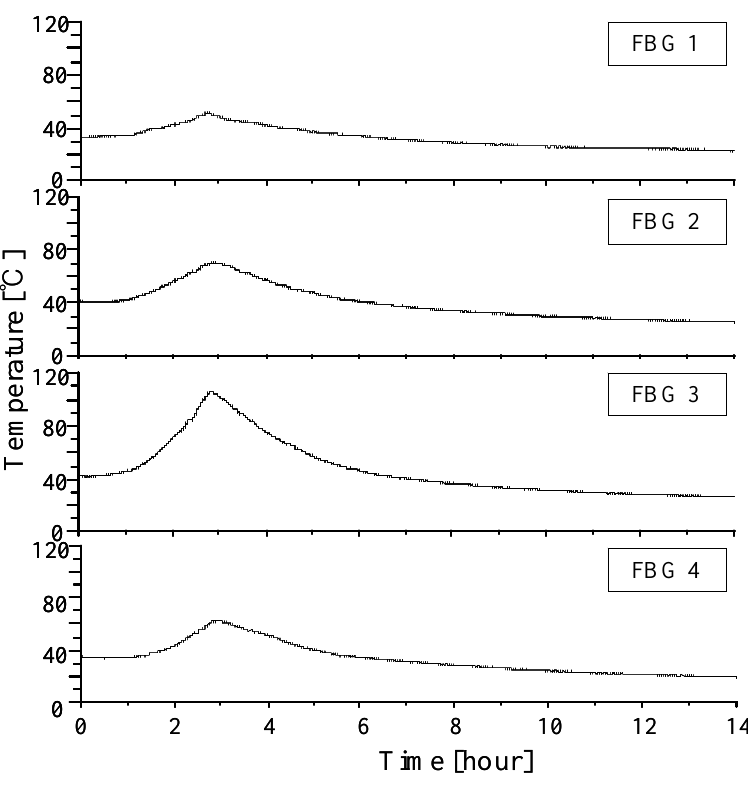
Figure7. Temperature variations of the high-voltage transformer.